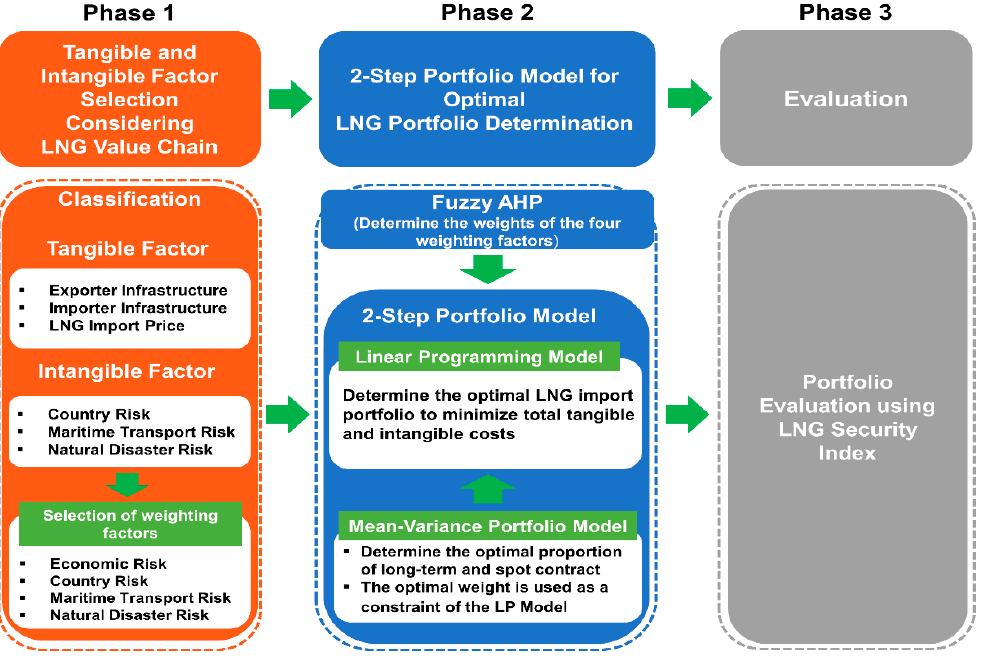
Figure 1. The analytical framework of this study.